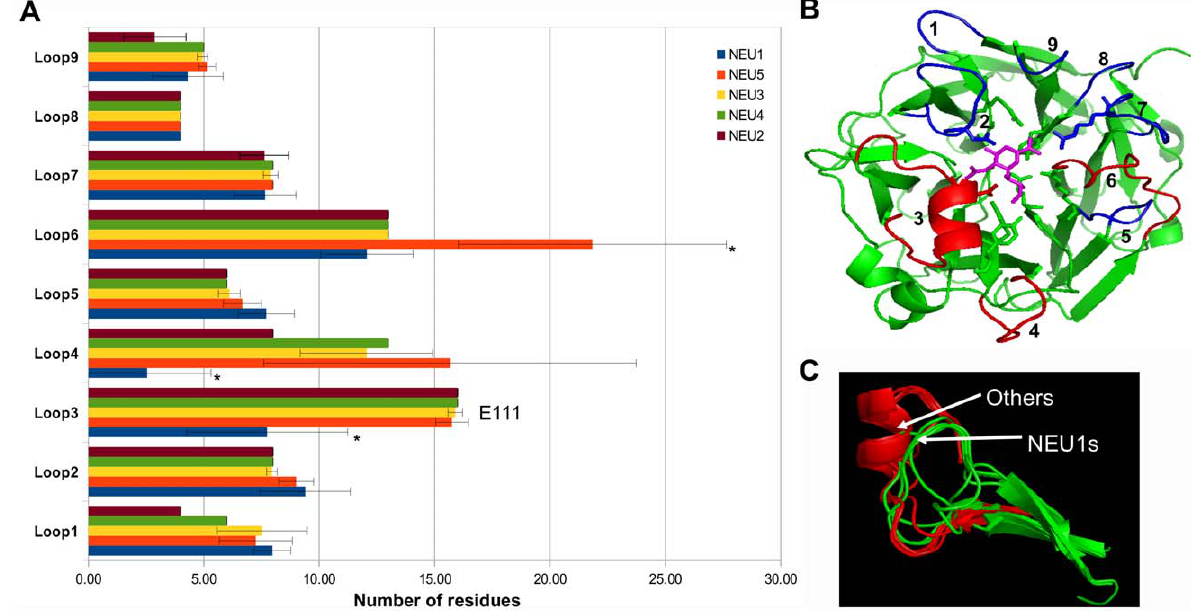
Figure 4. Analysis of the 9 loops emerging on the same side of the active site. (A) Horizontal bar chart representation of the mean length of the single loops in the 5 sialidase subgroups. Significant differences in length occur in Loop 3, 4 and 6 and are indicated with *. (B) Top view of the human NEU2 structure showing the 9 loops analyzed. Loops with significant length variations are near the glycerol portion of DANA and are represented in red, other loops are in blue. Catalytic key residues are represented as sticks and DANA inhibitor is colored in magenta. (C) Structural representation of Loop 3, containing the E111 residue, in different sialidases. Comparison of structural models revealed that this loop is considerably shorter in NEU1s than in other sialidases. The short a -helix structure containing E111 residue is absent in NEU1s. The positions of each loop within the human NEU2 structure are: Loop 0 (aa 16–18), Loop 1 (aa 15–18), Loop 2 (aa 42–49), Loop 3 (aa 107–122), Loop 4 (aa 183–190), Loop 5 (aa 238–243), Loop 6 (aa 261–274), Loop 7 (aa 299–306), Loop 8 (aa 329–332), Loop 9 (aa 357–359).